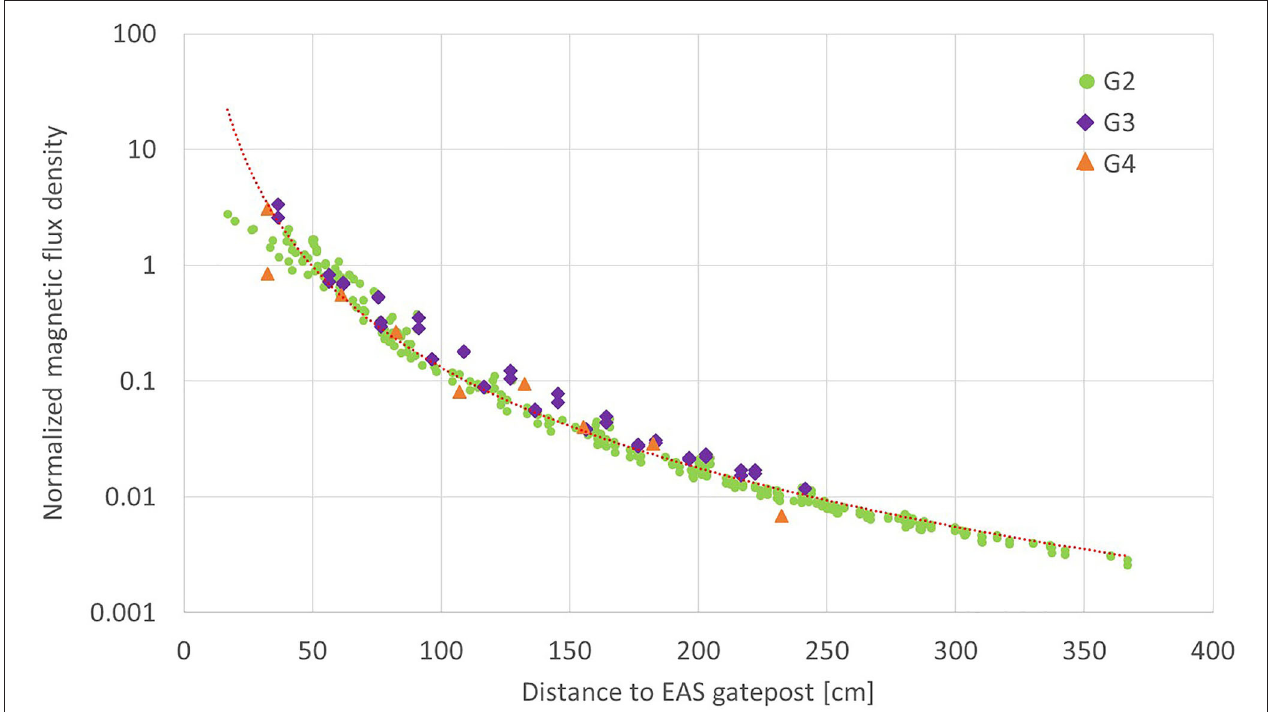
FIGURE 6 | Dependency of magnetic flux density on the distance to the nearest gatepost. The values are measured for G2, G3, and G4, and they are normalized by B IEC of each gate to allow comparison between different